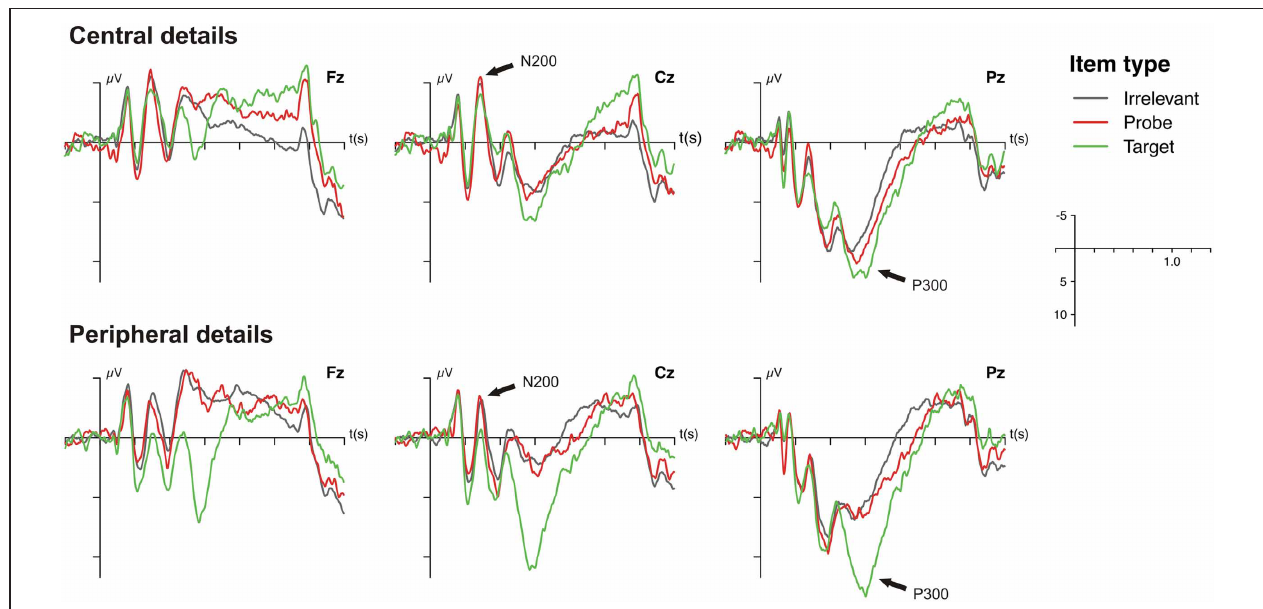
FIGURE 2 | Grand average event-related brain potentials (ERPs) as a function of question set (central vs. peripheral) and item type (target, probe, irrelevant) at Fz, Cz, and Pz. Voltage and time scales are depicted on the right side.